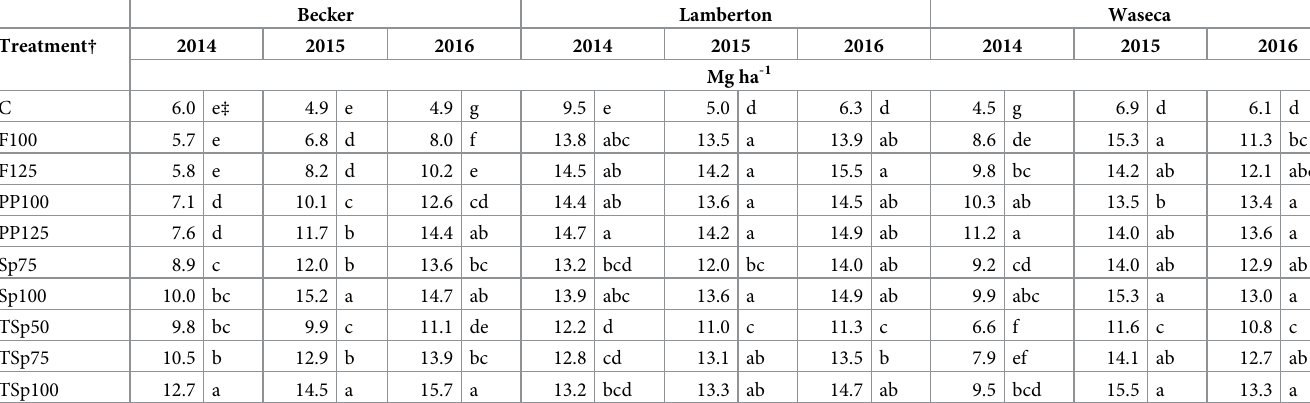
Table 4. Maize grain yield as affected by treatment, location, and year.